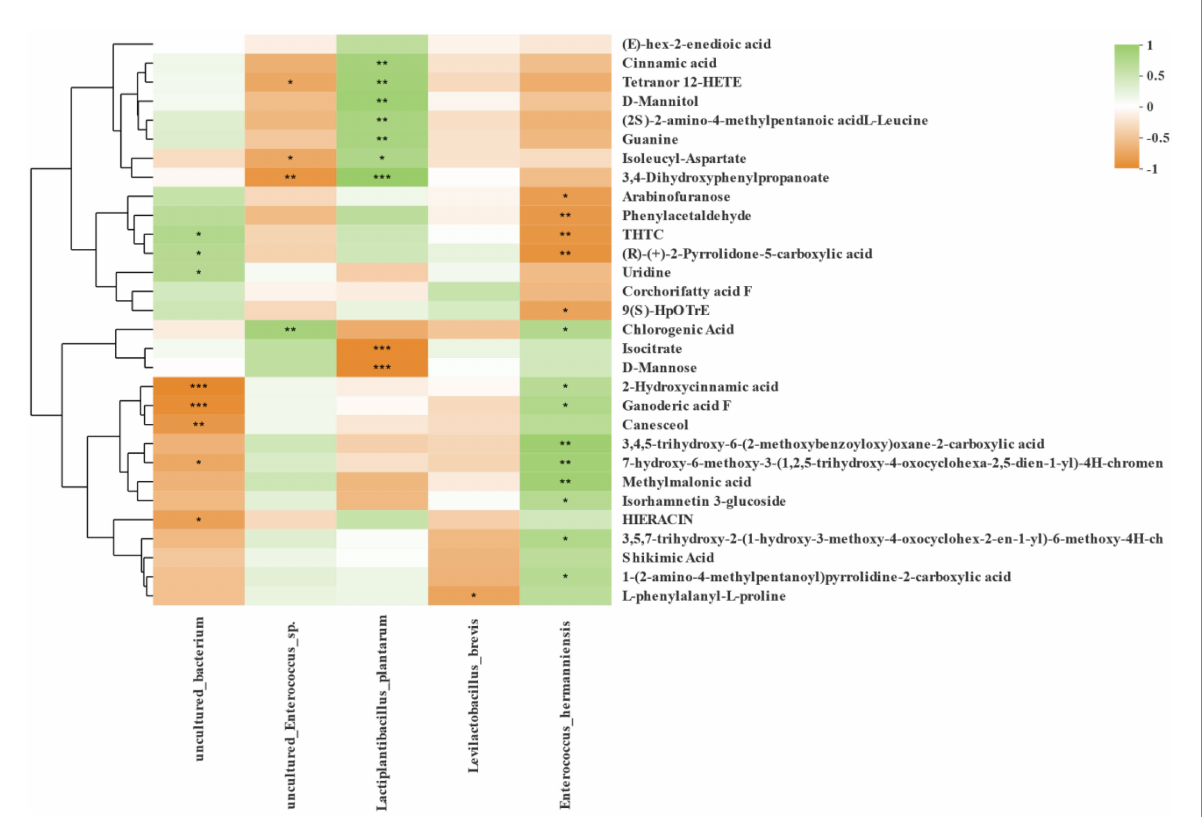
FIGURE 8 Correlation analysis of high abundance of species-level bacteria and metabolites in silage from three regions. Bacterial community information is displayed horizontally and the fermentation metabolites are displayed vertically. The corresponding value of the middle heat map is the Spearman correlation coefficient r, which ranges between − 1 and 1; r < 0 indicates a negative correlation (orange), r > 0 indicates a positive correction (green), and “*,” “**,” and “***” represent p < 0.05, p < 0.01, and p < 0.001,